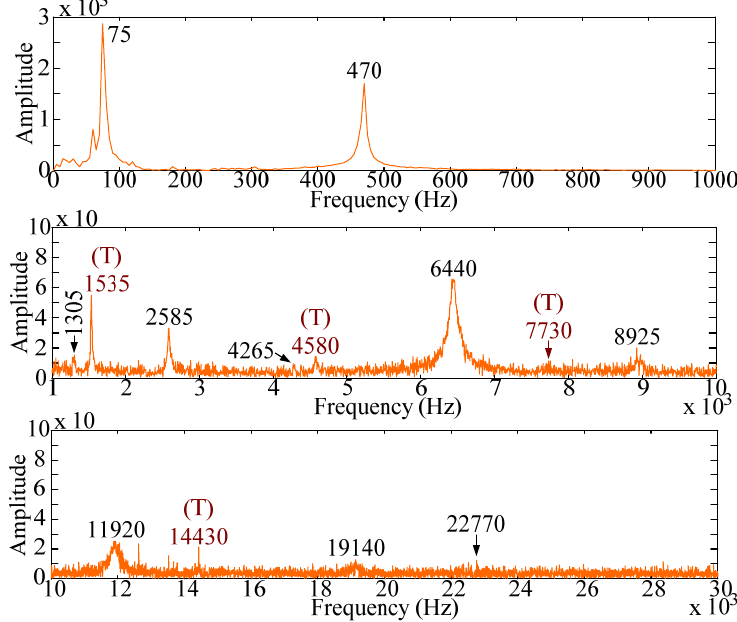
Figure 22. Frequency spectrum of PVDF 2 × 1 with impact on location